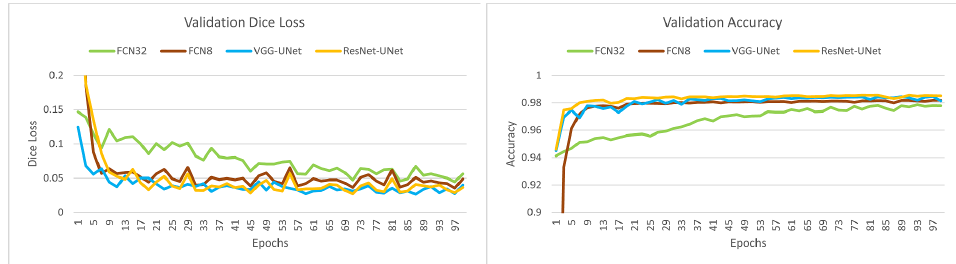
Figure 15. Loss and accuracy of FCN32, FCN8, VGG–UNet and ResNet–UNet networks in training.